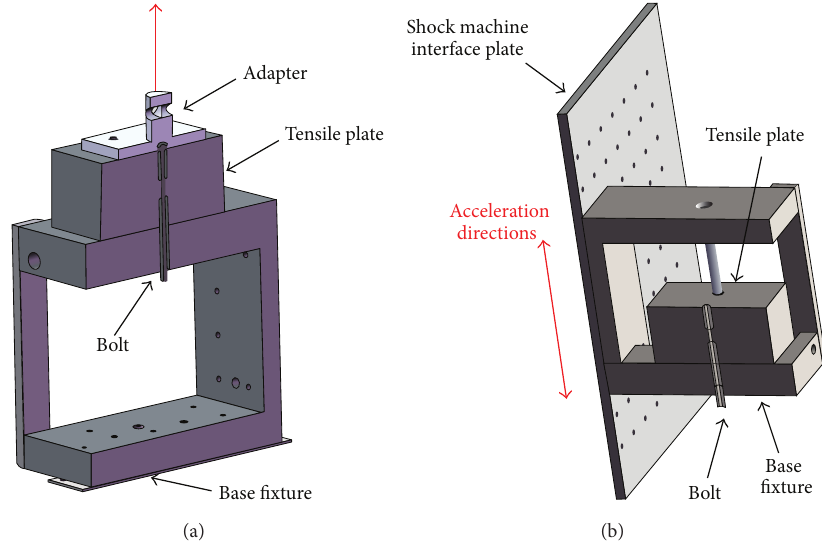
Figure 1: Section view of (a) static tension test and (b) dynamic tension